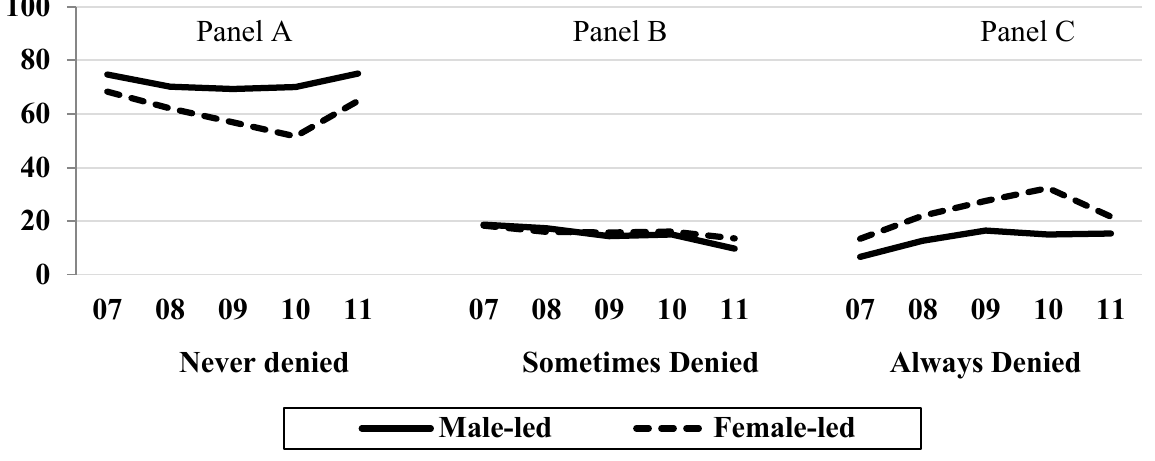
Figure 2: Rates of Funding Denial By Gender,